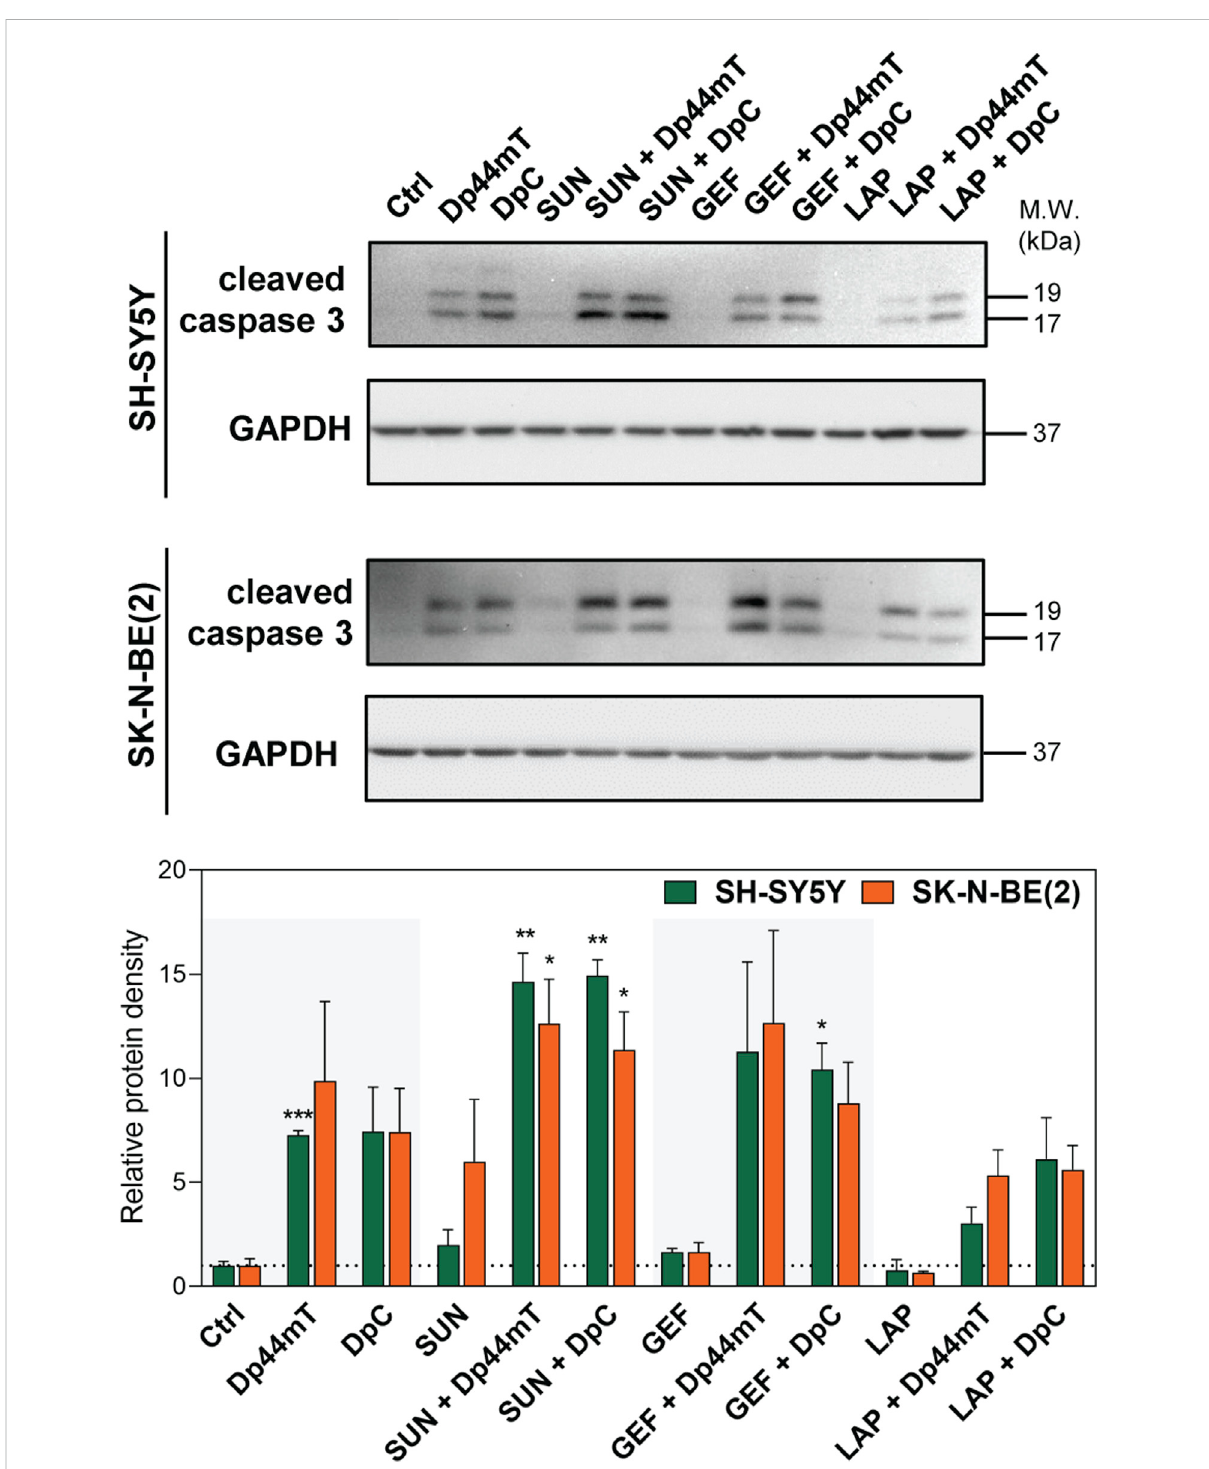
FIGURE 4 Western blotting of cleaved caspase-3, a marker of apoptosis, in SH-SY5Y and SK-N-BE(2) neuroblastoma cells. The changes in caspase-3 cleavage were detected after 72-hour incubation with either a control medium or a medium containing the drugs, including TKIs (SUN, GEF, or LAP) and thiosemicarbazones (Dp44mT or DpC) alone or in combination. The drugs were used at concentrations of IC 50 for 72 h as listed in Table 2. Representative blots(left)and theirdensitometricquanti fi cation(right)ofthree independentexperiments are shown. The dataare presented as mean ± SD ( n = 3) normalized to GAPDH that was used as the protein-loading control. * p < 0.05, ** p < 0.01, *** p < 0.001 relative to the untreated controlsamples;the p valueswereevaluatedusingWelch ’ sANOVAfollowedbyDunnett ’ sT3multiplecomparisonstest.Thedottedhorizontallinein the graph represents the control levels of cleaved